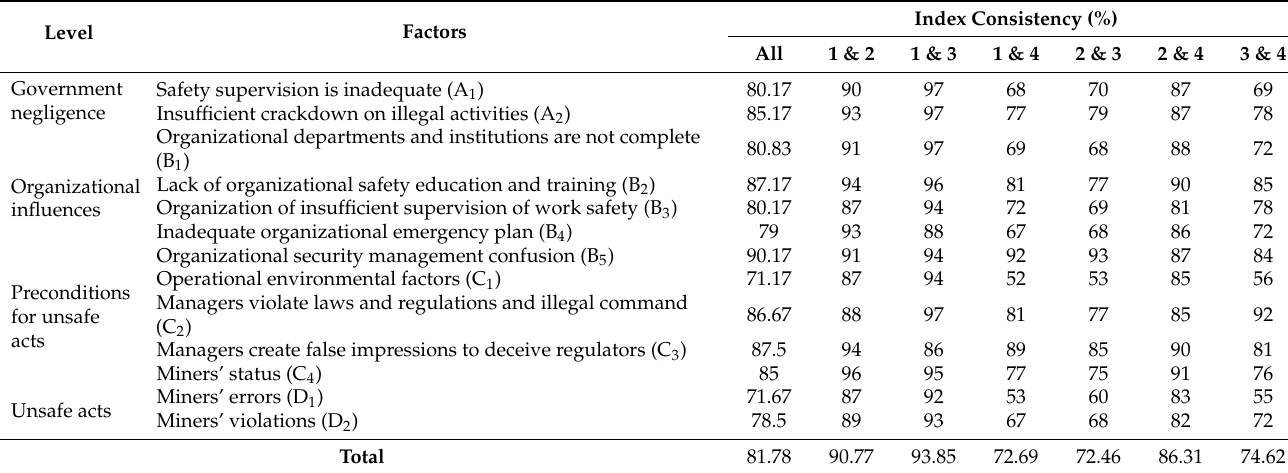
Table 2. Reliability test results of the improved HFACS